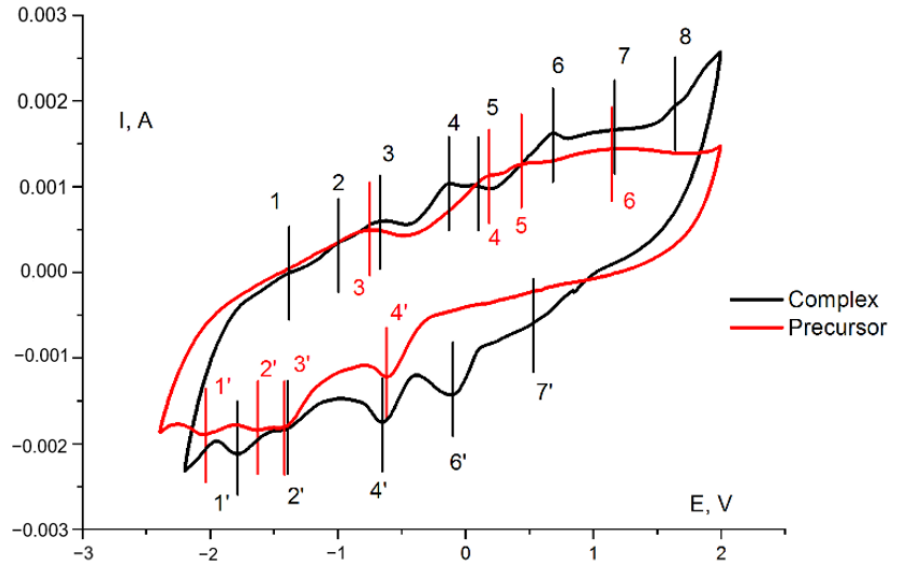
Figure 6. Cyclic voltammogram (second cycle) of 1 (black curve) and a (Bu 4 N) 4 [Mo 8 O 26 ] (red curve) in a paste electrode in acetonitrile with supporting electrolyte (0.10 M Bu 4 NPF 6 ) at a sweep rate of 20 mV/s. Potentials vs. saturated Ag/AgCl reference electrode. Table 2. Characteristics of half-wave potentials, as well as anodic and cathodic current peaks of the